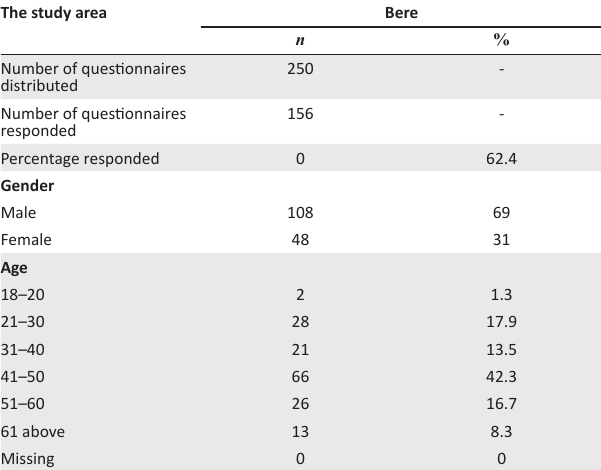
TABLE 2: Demographic profile and composition of households’ survey